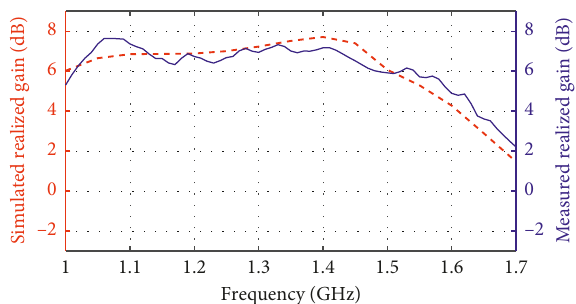
11 evolution vs frequency.